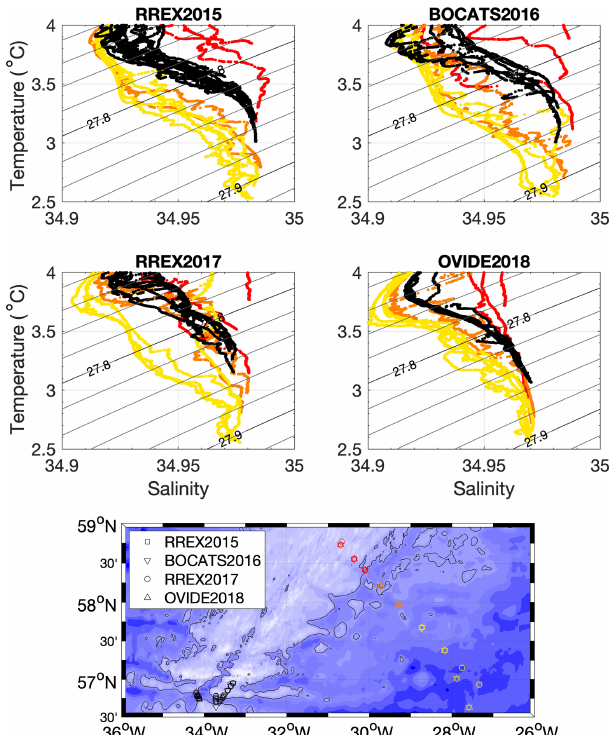
Figure 3. θ – S diagram of the (color) southward along-ridge flow and (black) westward cross-ridge flow through the BFZ for each cruise indicated in the lower panel. The black line outlines the 2100m